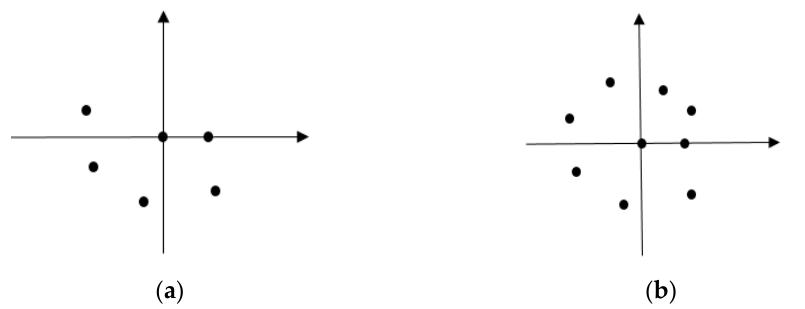
Figure 4. Detection of the border point. ( a ) Border point, ( b ) no border points.